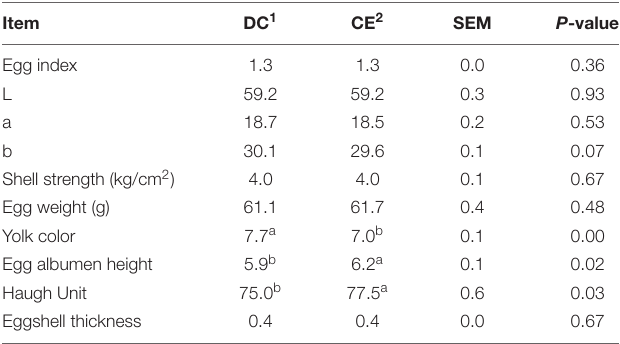
TABLE 3 | Effect of supplemental multi-enzyme on the egg quality of aged breeding hens ( n =